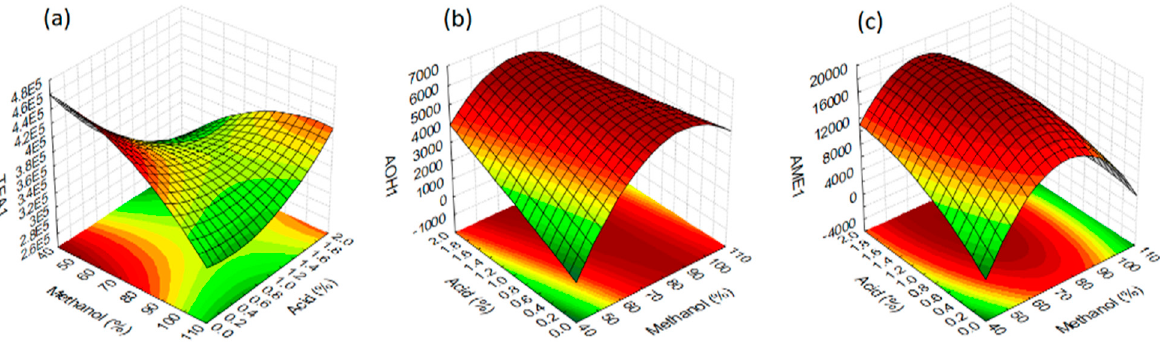
Figure 2. Response surfaces for TeA ( a ), AOH ( b ) and AME ( c ), as a function of the methanol and acid percentage compositions derived from a central composite design (slice at the extraction time of 45